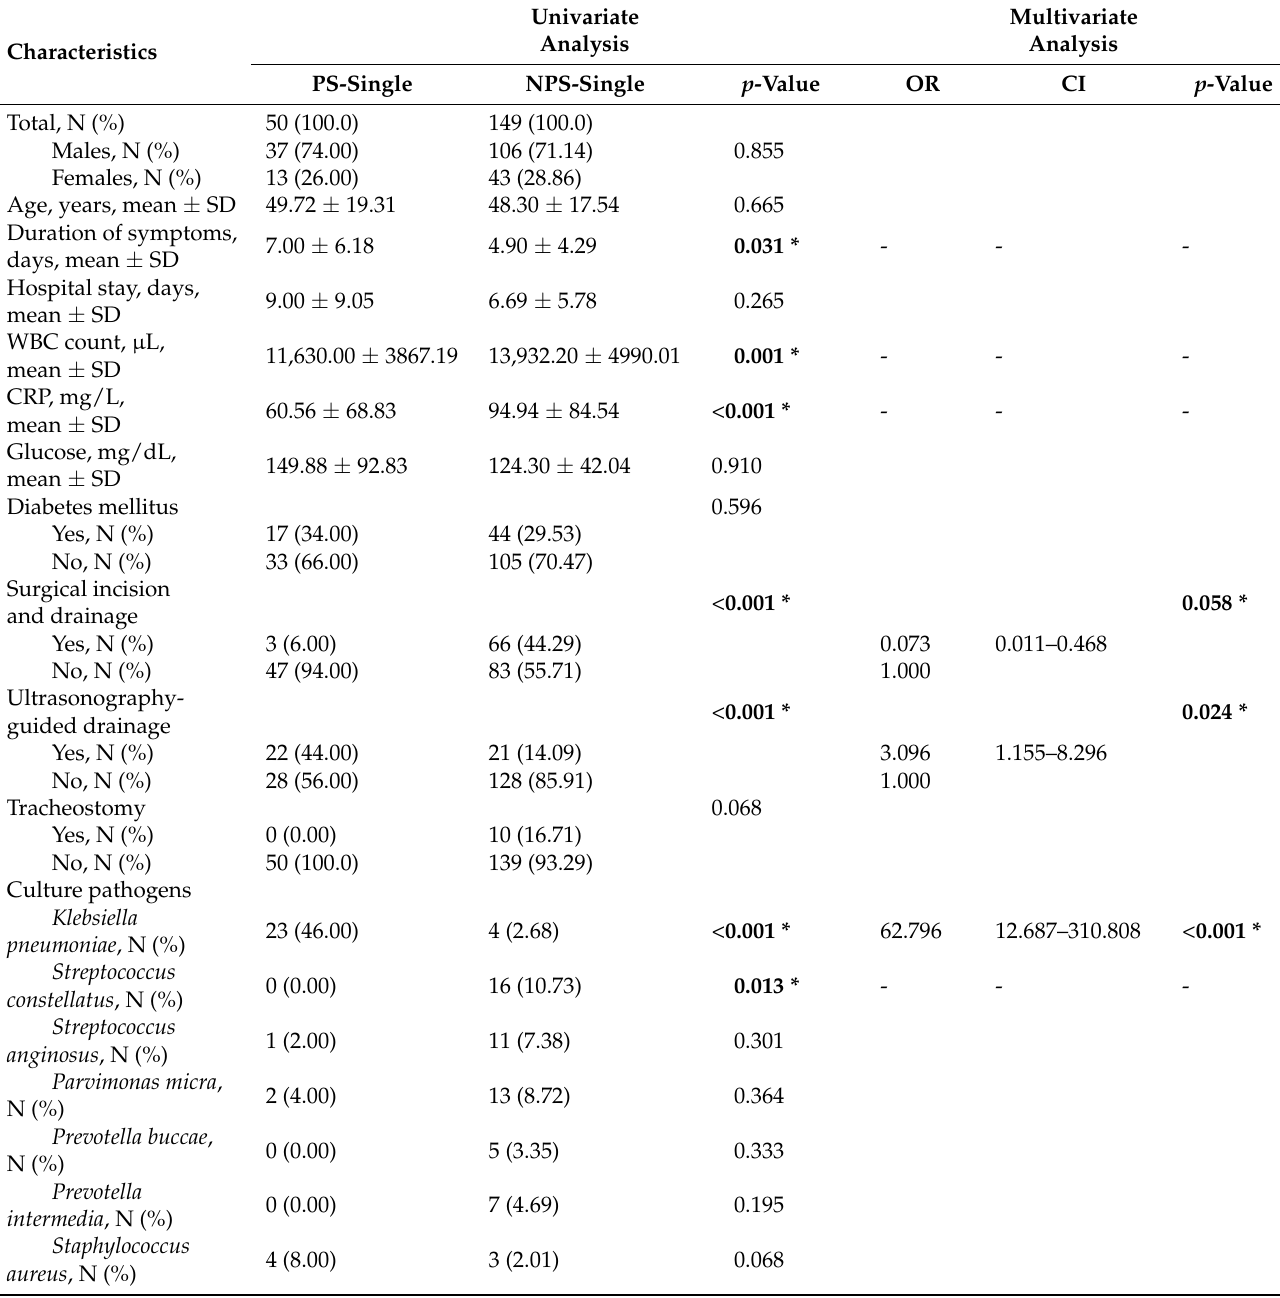
Table 3. Clinical data from the PS-single and NPS-single deep neck infection